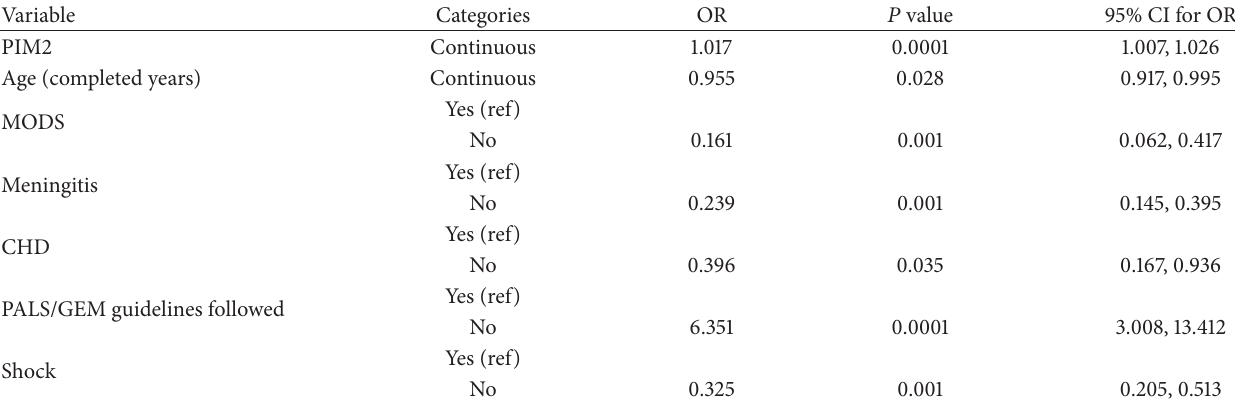
Table 1: Findings of logistic regression analysis with PIM2 as a predictor in the